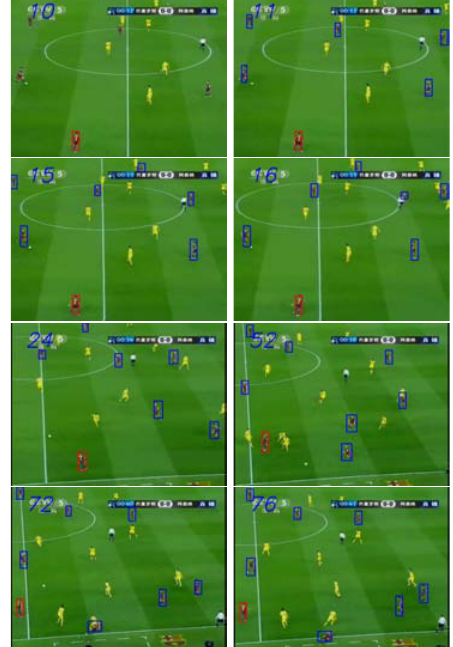
Fig. 8. Multiple objects tracking results.